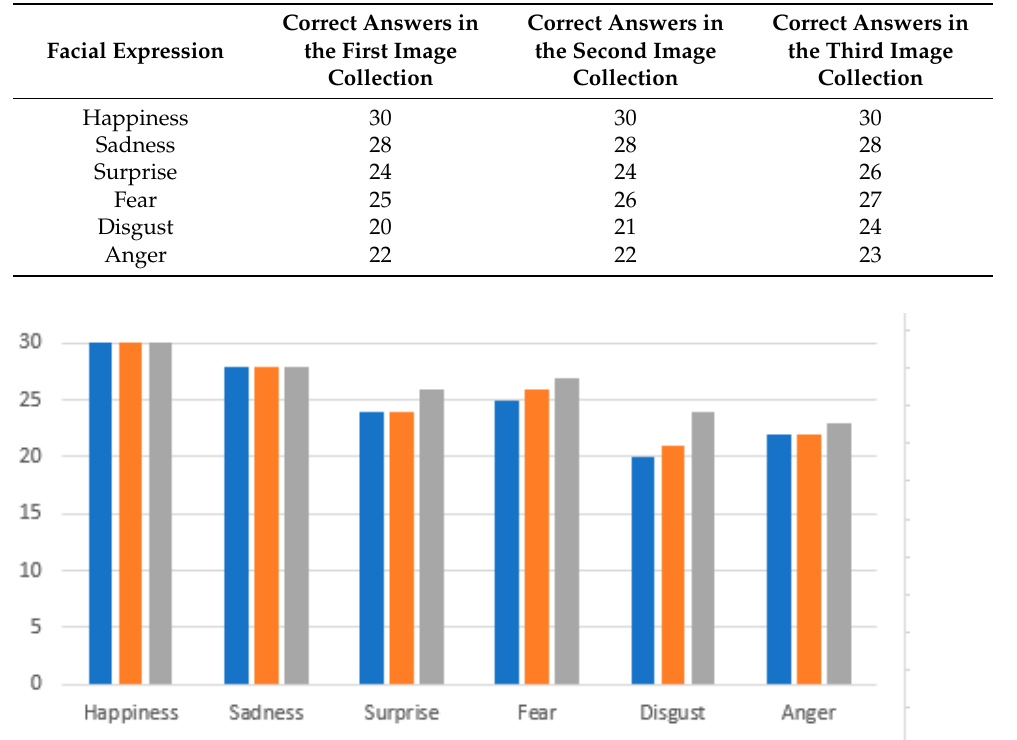
Table 4. Caregivers’ reports showing the correct answers for the children’s interaction with the three face collections for both days, sorted by facial expression.